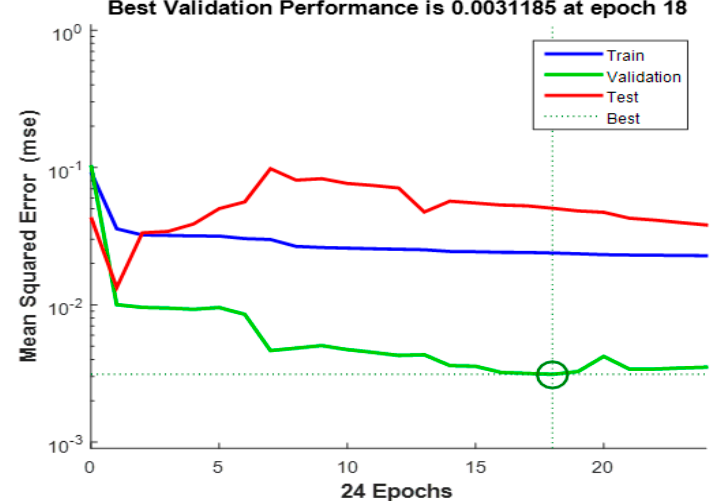
Figure 29. Best validation performances obtained for neural architecture with 7 neurons in hidden layer.